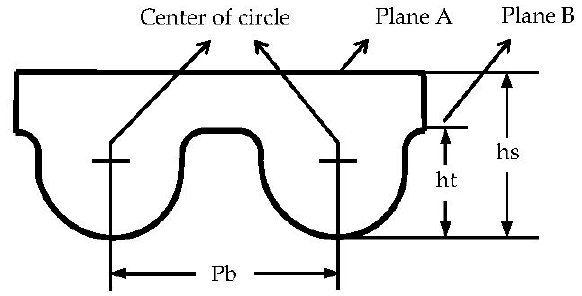
Figure 1. Synchronous belt parameters.